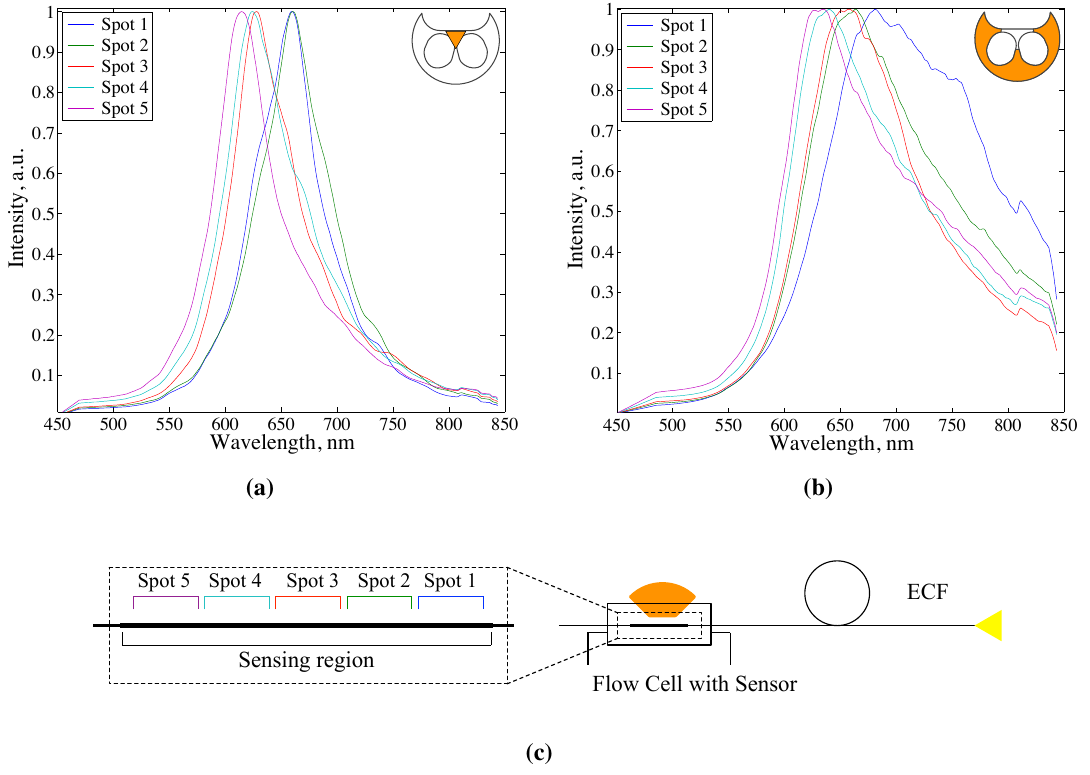
Figure 4. Scattered spectra taken from different spots on a sensing region of the exposed core fibre (ECF) SPR sensor in case of ( a ) core coupling, and ( b ) support structure coupling (as shown on the insets). Refractive index of the outer dielectric medium is 1.33; ( c ) Schematic diagram of five equidistant spots on the sensing region of ECF SPR sensor. Sensing region length is 15 mm .